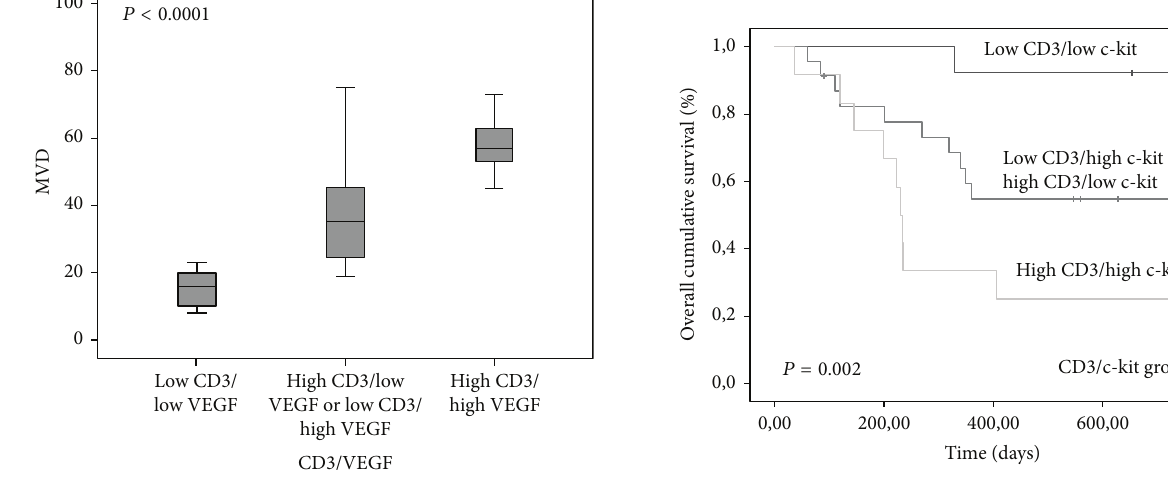
Figure 5: Association of MVD and CD3/VEGF groups in malignant canine mammary tumors.